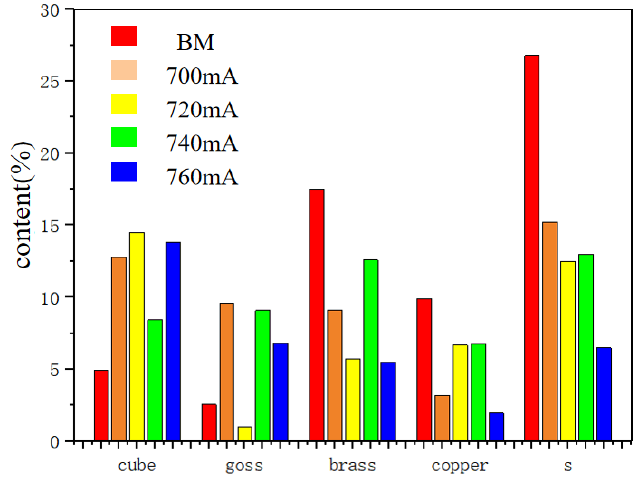
Figure 12. Austenite Texture Content of Inconel 625 Original Sample and Sample after Electron Beam Scanning at 700 mA to 760 mA.